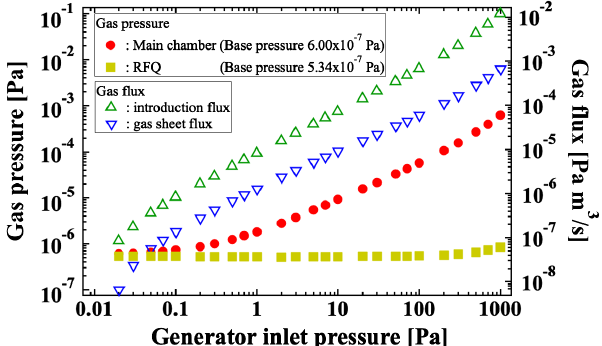
FIG. 8. The cover chamber and the gas sheet generator. The distance from the exit of the gas sheet generator to the slit is 10 mm.